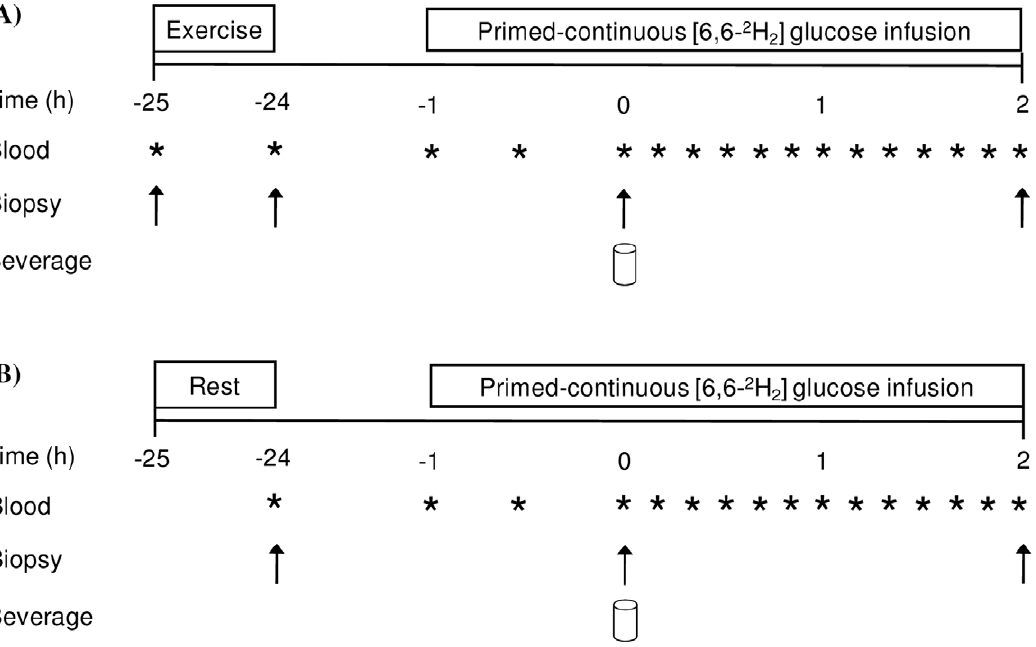
Figure 1. Schematic diagram of the study protocol. (A) Indicates protocol for exercise only and exercise plus protein participants. (B) Indicates protocol for non-exercised control participants.